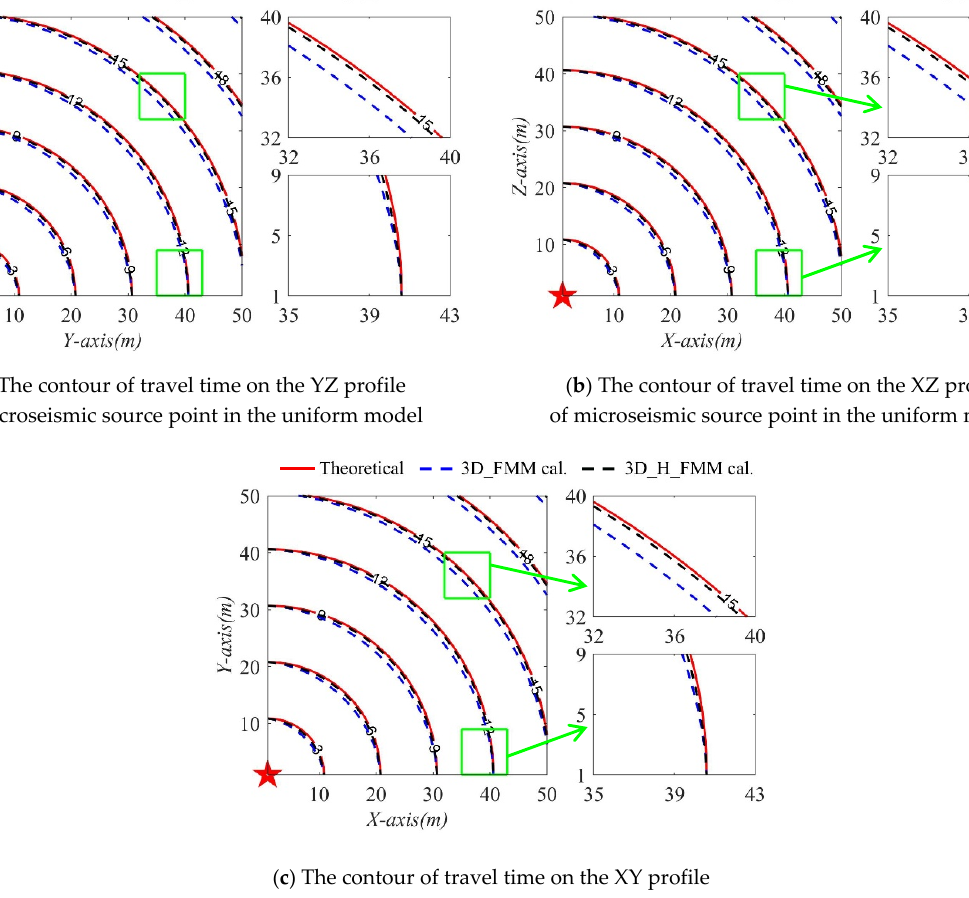
Figure 5. The contour of travel times of the three profiles of microseismic source point in the Case A: small-scaled homogeneous model.